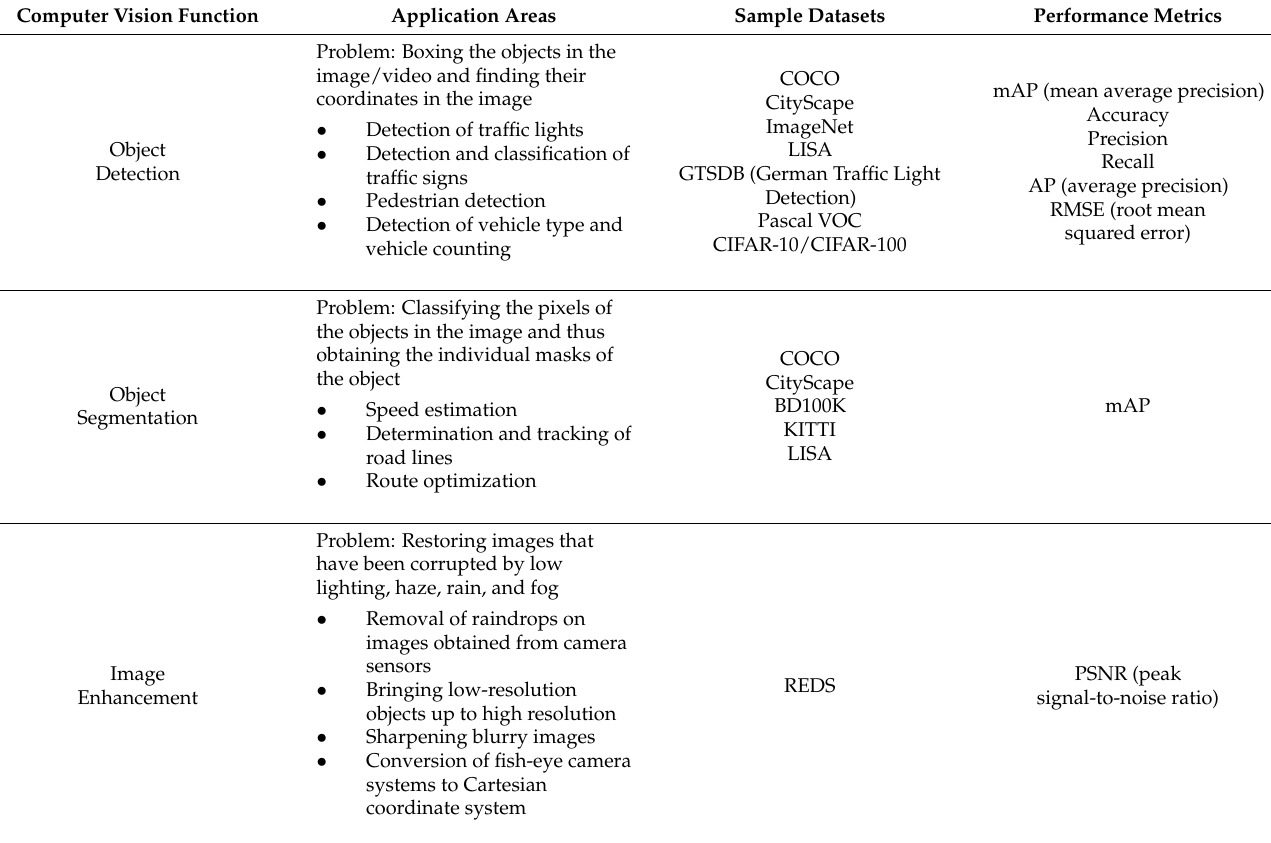
Table 1. Problems Addressed by CV Techniques in the Field of